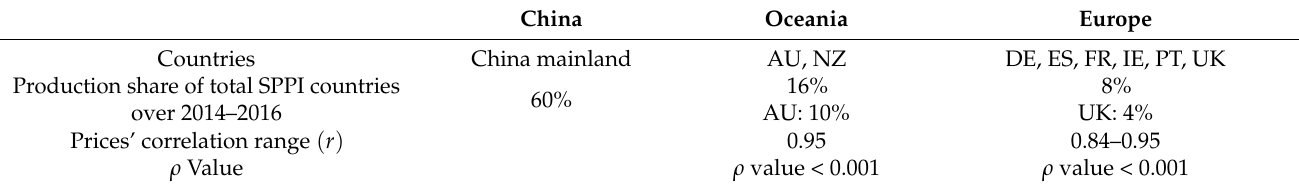
Table 3. Overview of the introduced regional SPPIs, source: own illustration.